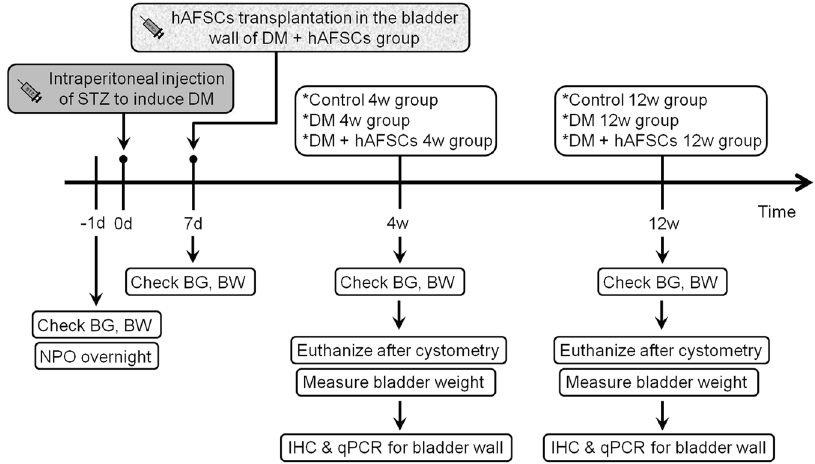
Figure 1. Schema of the experimental procedure. BS = blood sugar, BW = body weight, DM = diabetes mellitus, hAFSCs = human amniotic fluid stem cells, IHC = immunohistochemistry, NPO = nill per os, PCR = real-time polymerase chain reaction, STZ =